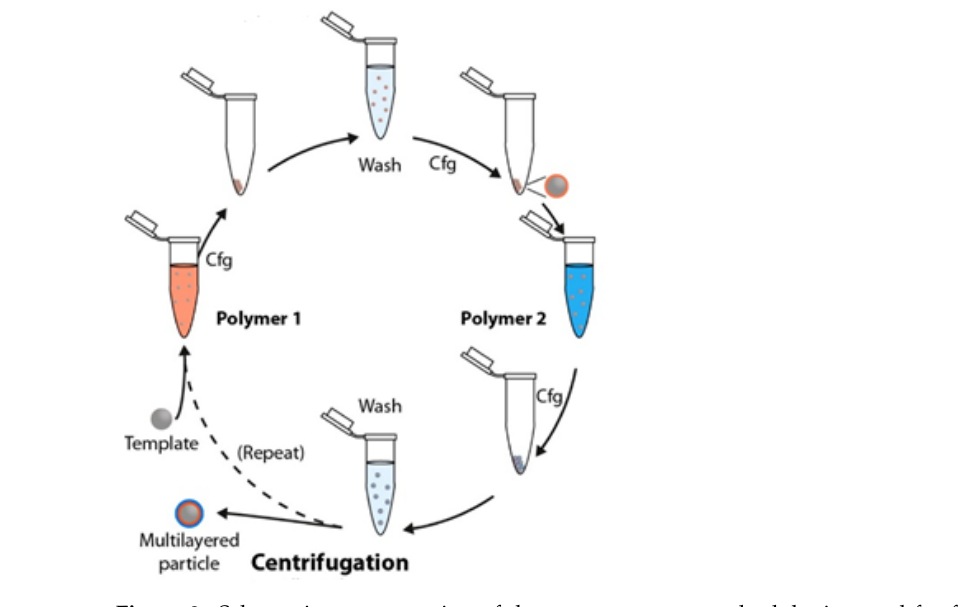
Figure 2. Schematic representation of the most common methodologies used for fabricating PEMUCs using colloidal particles as templates. Reprinted from Yan et al. [52], Copyright (2014), with permission from American Chemical Society.